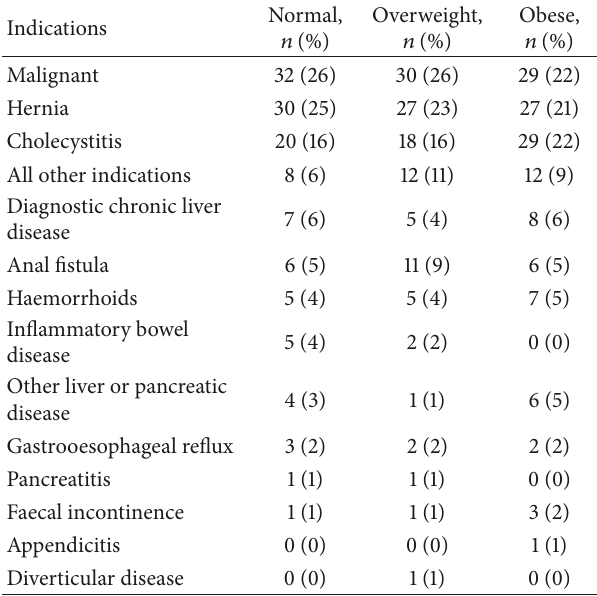
Table 2: Surgical